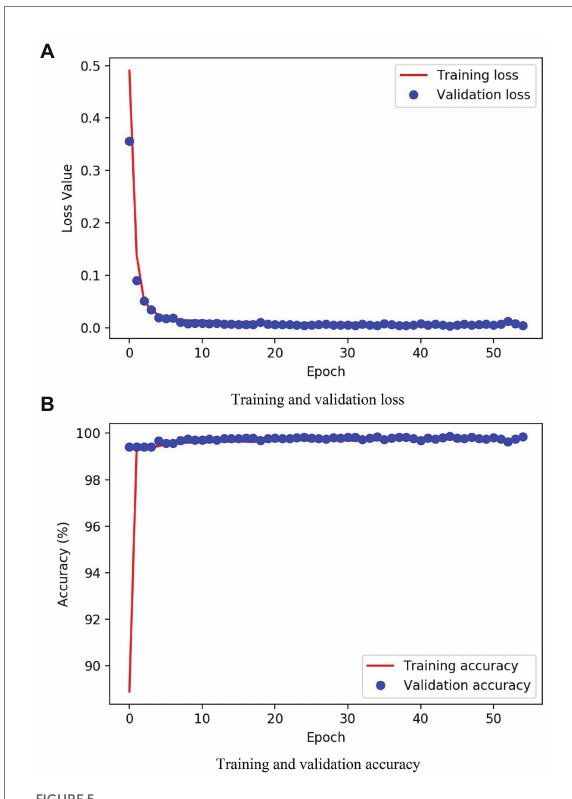
FIGURE 5 Loss and accuracy changes during training: (A) Training and validation loss; (B) Training and validation